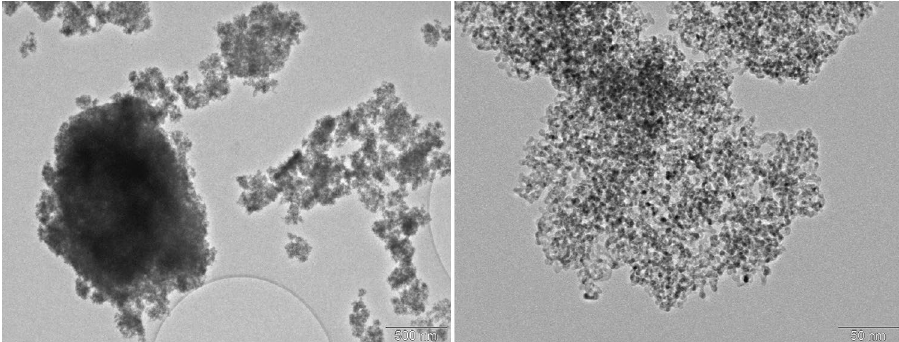
Fig. 5 TEM pictures of calcined zirconia powder (from azeo- tropic dried